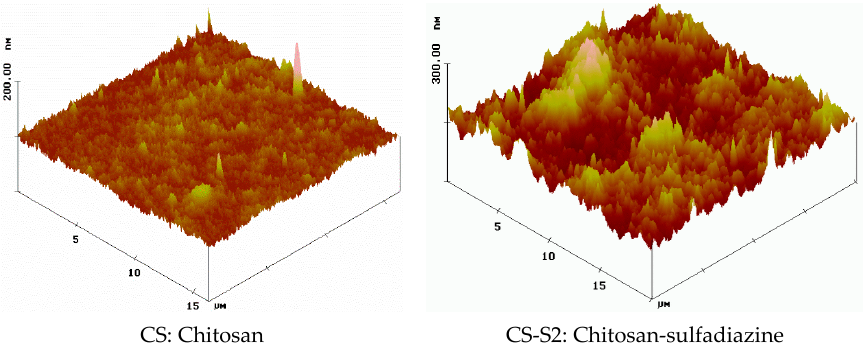
Figure 2. AFM image of chitosan (CS) and of chitosan-sulfadiazine (CS-S2) films.